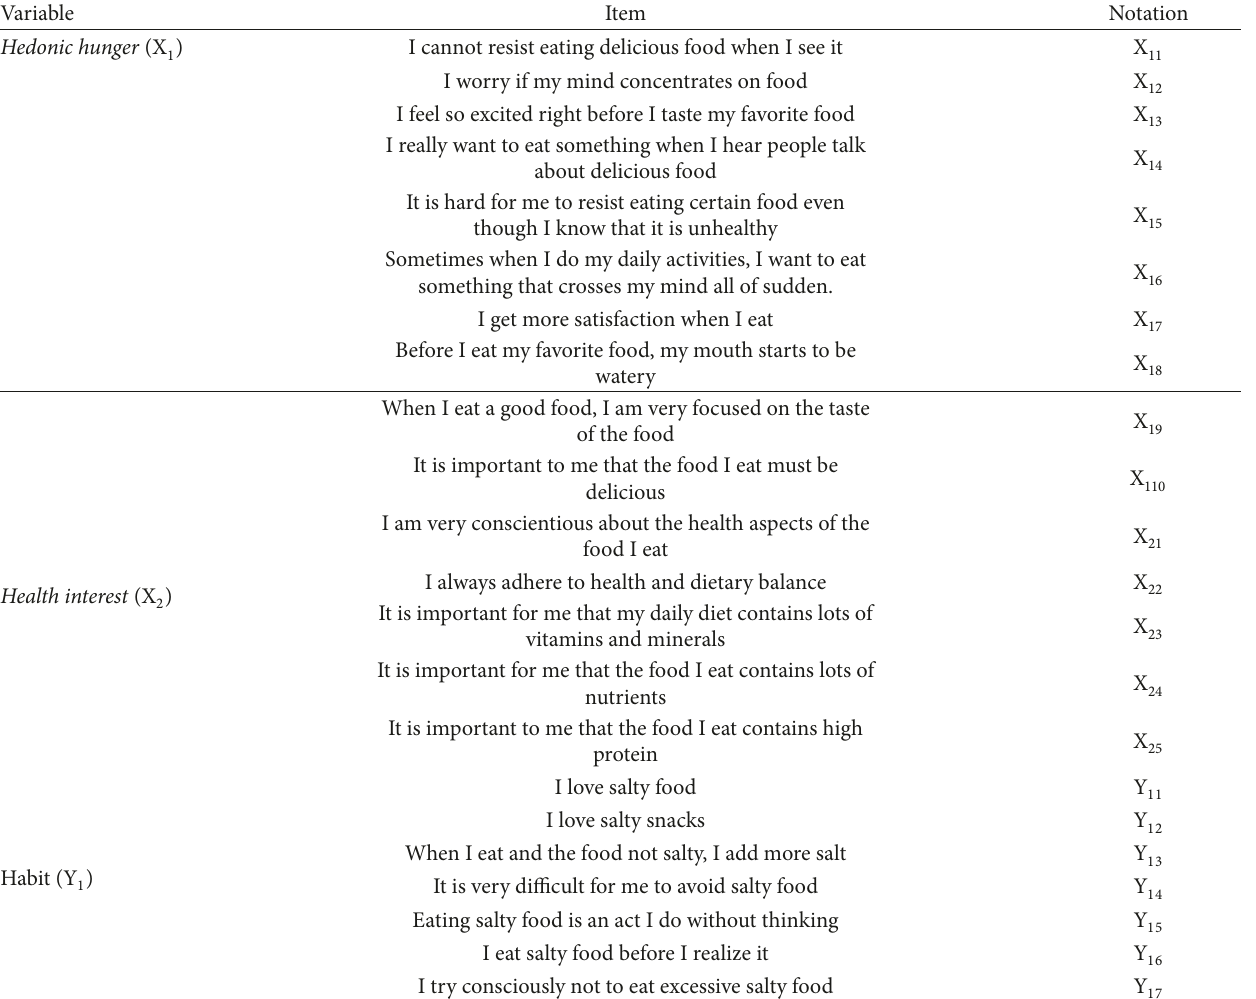
Table 1: Variable and Research